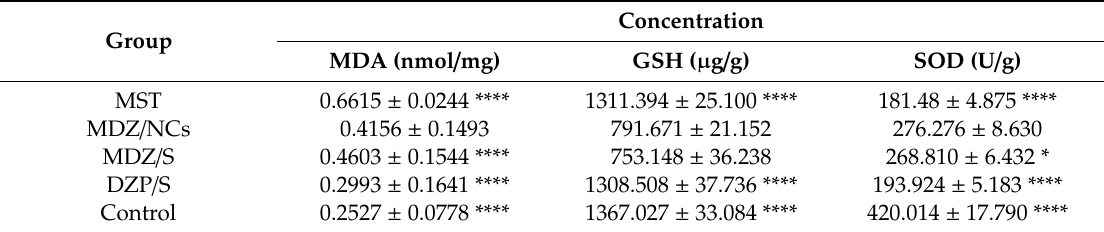
Table 8. Protective e ff ects of MDZ / NCs on the